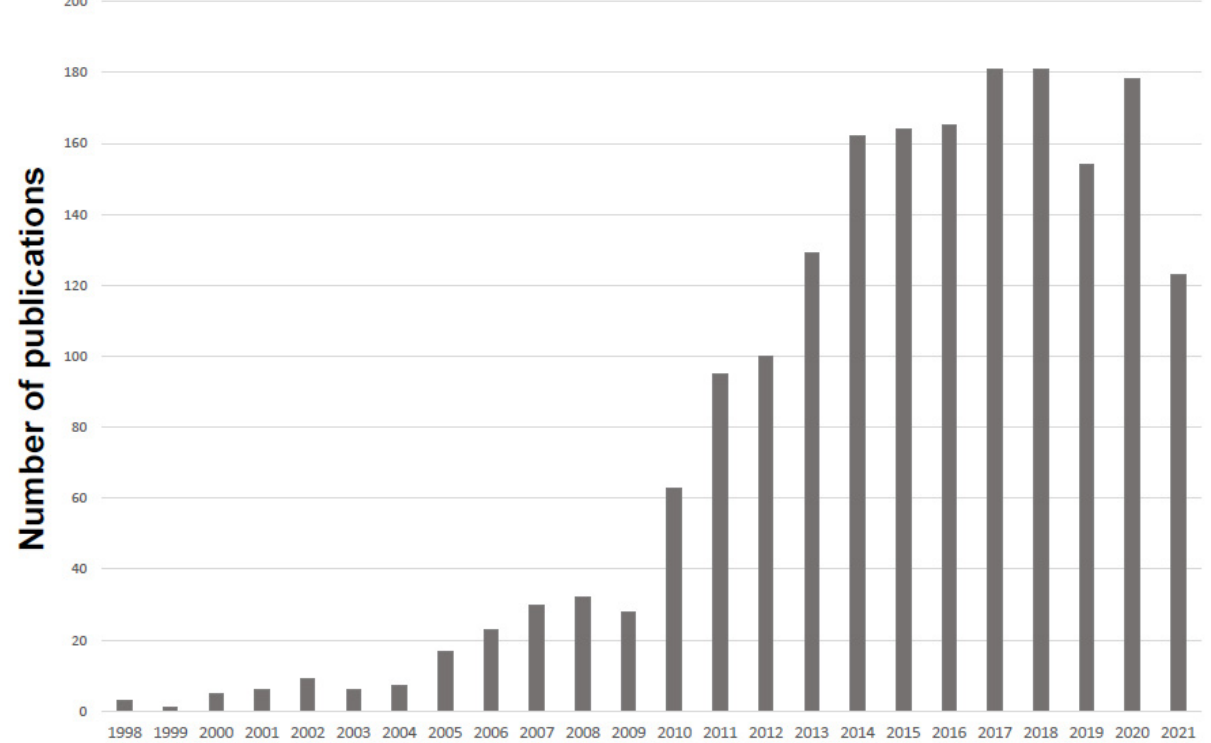
Figure 1. Trends in research reports on microbial identification using MALDI-TOF mass spectrometry. We used a PubMed literature search as of 17 December 2021, using the terms MALDI-TOF, MS, and Bacterial identification.